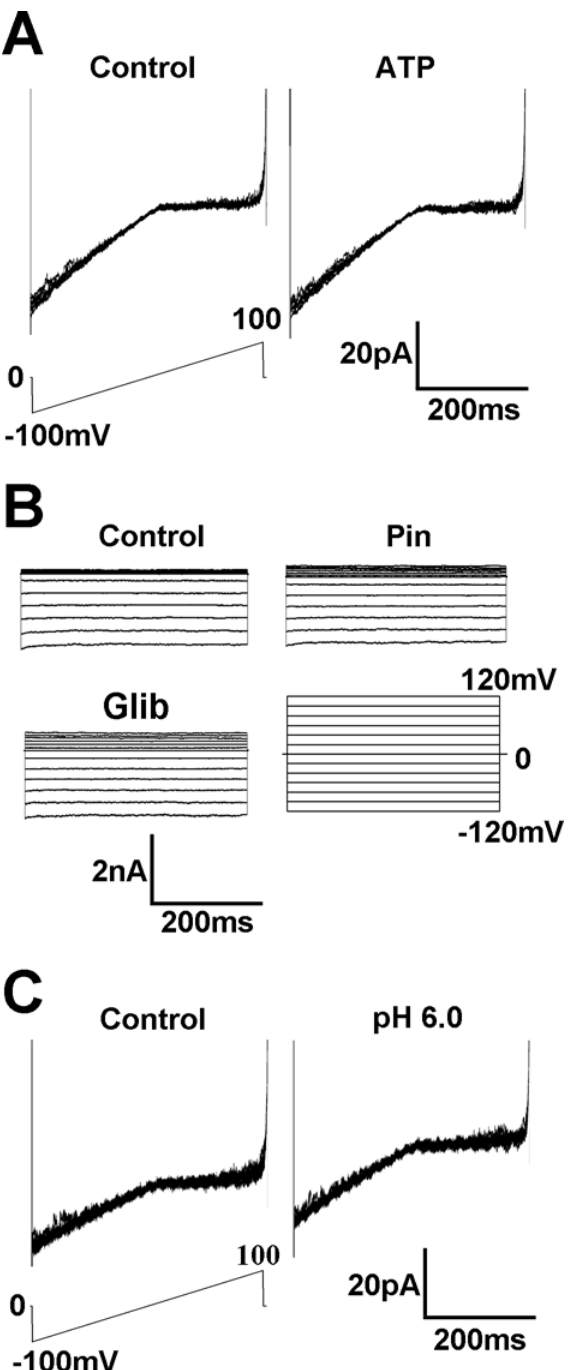
Fig 5. These currents are insensitive to ATP and pH. ( A) In the inside-out patches, exposure of K 2 ATP (1 mM) on the internal membrane did not have any effect on the currents. (B) Specific K ATP channel